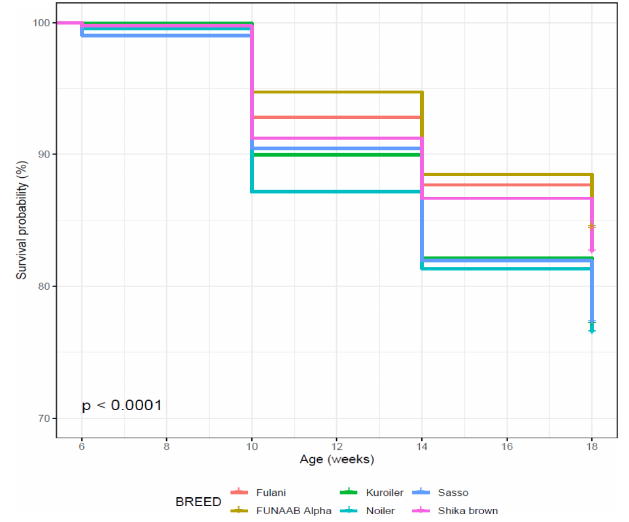
Figure 5. Effect of breed on overall on-farm cumulative hazard of birds (male and female) during growing phase in ACGG Nigeria project zones (6–18 weeks)